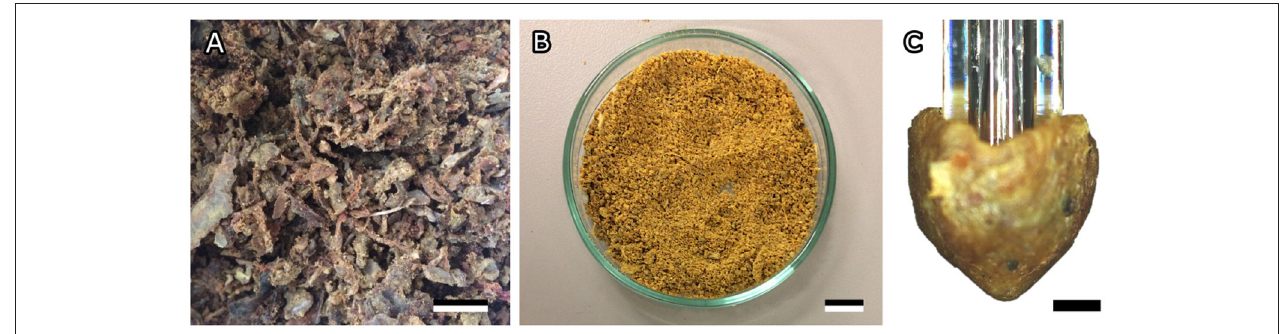
FIGURE 1 | Bee propolis. (A) Raw propolis as collected from the hive. (B) Homogenized propolis powder. (C) Cone-shaped propolis sample used for adhesion tests. Scale bar: 1cm (A,B) , 500 µ m (C) .